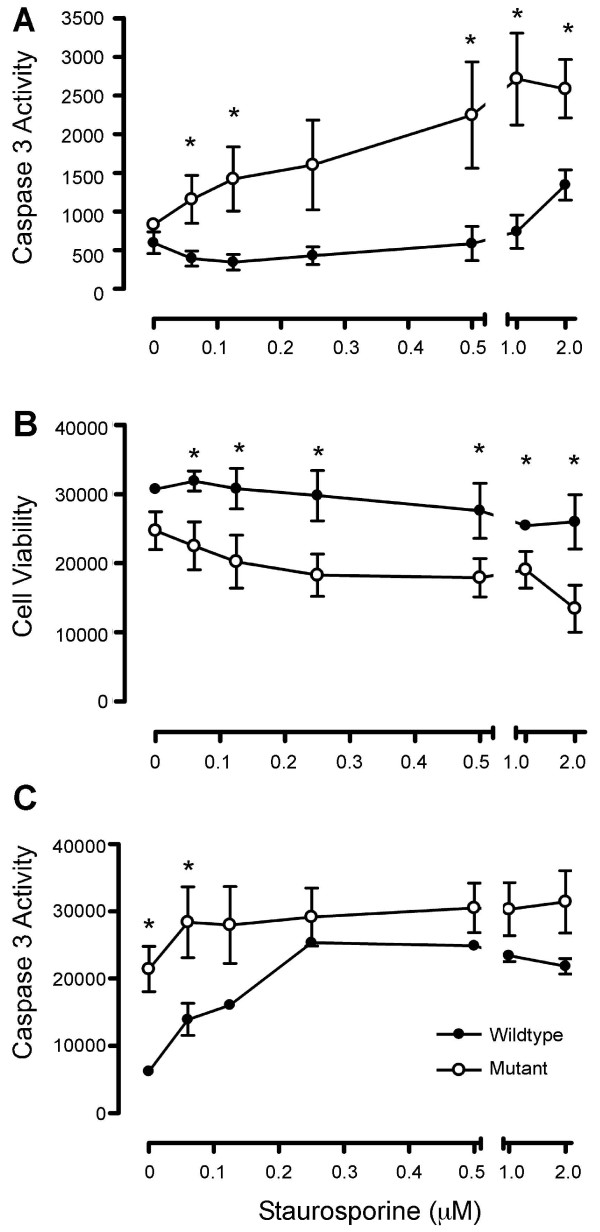
Expression of wild-type MMP-28 protects against staurosporine-induced apoptosis in A549 and BEAS-2B cells. A549 (A, B) or BEAS-2B (C) cells expressing wild-type MMP-28 (closed circle) or mutant MMP-28 (open circle) were plated on a 96-well plate with increasing doses of staurosporine in serum-free medium (0 - 2 μM). After 16 h incubation with staurosporine or serum-free medium, the level of caspase 3/7 activity was determined by measuring the fluorescence of a cleaved caspase 3/7 substrate (A,C). In separate experiments, the cell viability was assessed by Alamar Blue staining (B).